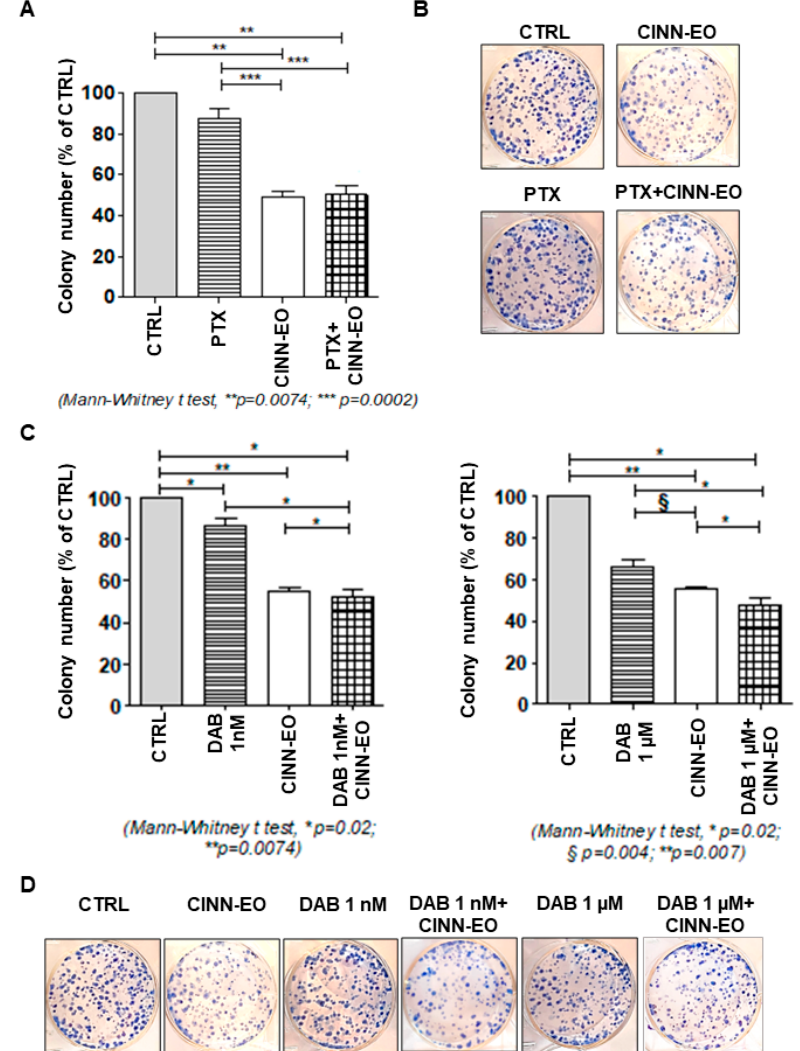
Figure 7. Effects of the combination of CINN-EO with the drugs paclitaxel (PTX) and dabrafenib (DAB) on M14 cell survival. ( A ) Colony formation assay on M14 cells exposed to CINN-EO alone or in combination with PTX for 24 h. The cell survival percentages were calculated as the percentages of colonies formed in each sample versus the percentage of colonies formed in untreated controls. ( B ) Images of the stained colonies obtained in each sample. ( C ) Colony formation assay on M14 cells exposed to CINN-EO alone or in combination with DAB 1nM (left panel) or 1 µ M (right panel) for 24 h. The cell survival percentages were calculated as the percentages of colonies formed in each sample versus the percentage of colonies formed in untreated controls. ( D ) Images of the stained colonies obtained in each